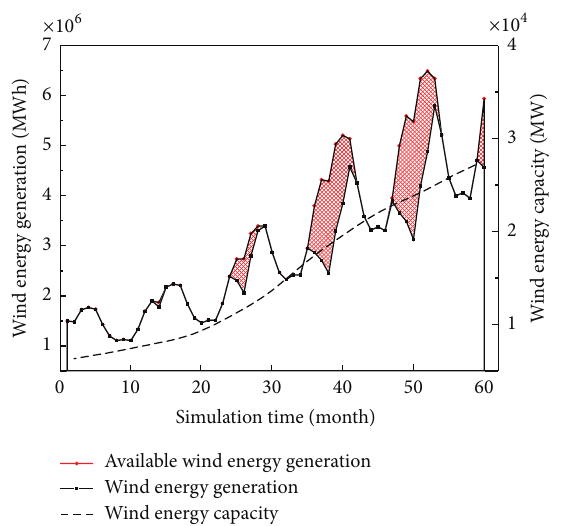
Figure 6: The percentage of utilization hours of wind energy generation.